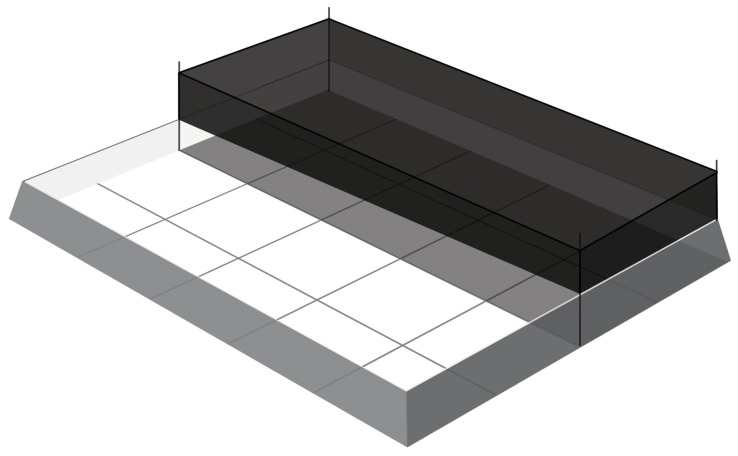
Diagram of experimental design illustrating the two experimental treatments: shaded (under a shade cloth made of plastic mesh) and unshaded (uncovered nests).